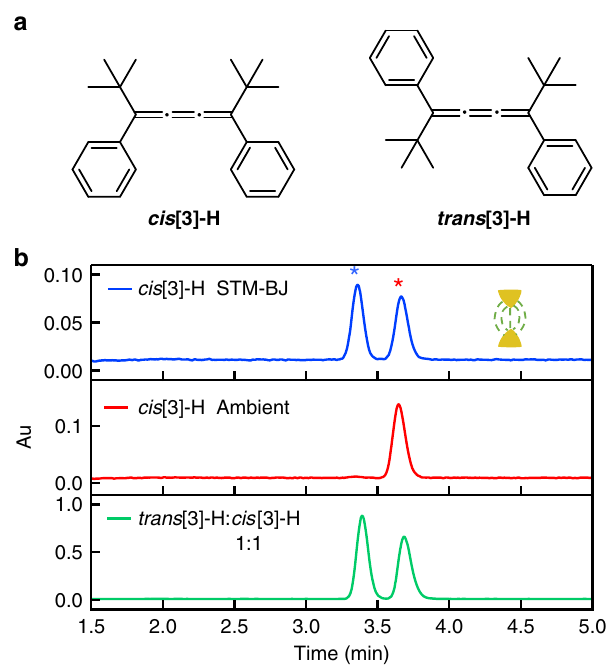
Fig. 3 Isomerization reactions of cumulenes without aurophilic linkers. a Molecular structure of cis[3]-H and trans[3]-H cumulene isomers. b HPLC spectra for cis[3]-H collected after STM-BJ measurements of ~300 h in TD at 0.5 V (blue); the same solution kept outside the setup for the same amount of time (red); a 1:1 mixture of cis[3]-H and trans[3]-H (green). The signature peak of cis[3]-H and trans[3]-H is denoted by the red and blue stars, respectively